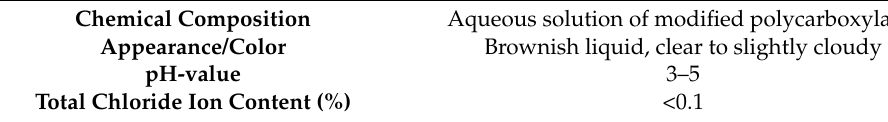
Table 4. Chemical compositions of superplasticizer.